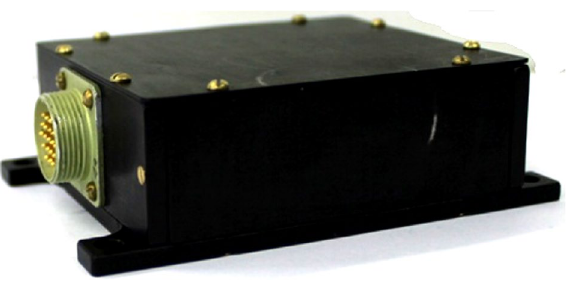
Figure 5. There is one of two magnetometers installed on the small spacecraft prototype "Aist". (cited in 4